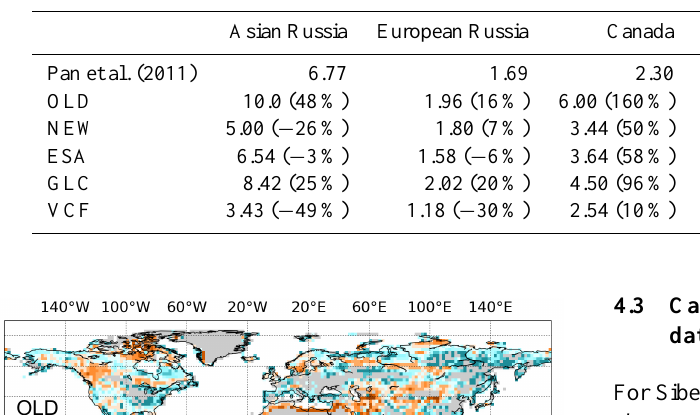
Table 4. Forest areas (Mkm 2 ) for different countries/regions simulated by models (OLD and NEW) and estimated from land-cover products (ESA, GLC, VCF), in comparison with those from Pan et al. (2011). The relative differences compared to Pan et al. (2011) are given in parentheses.